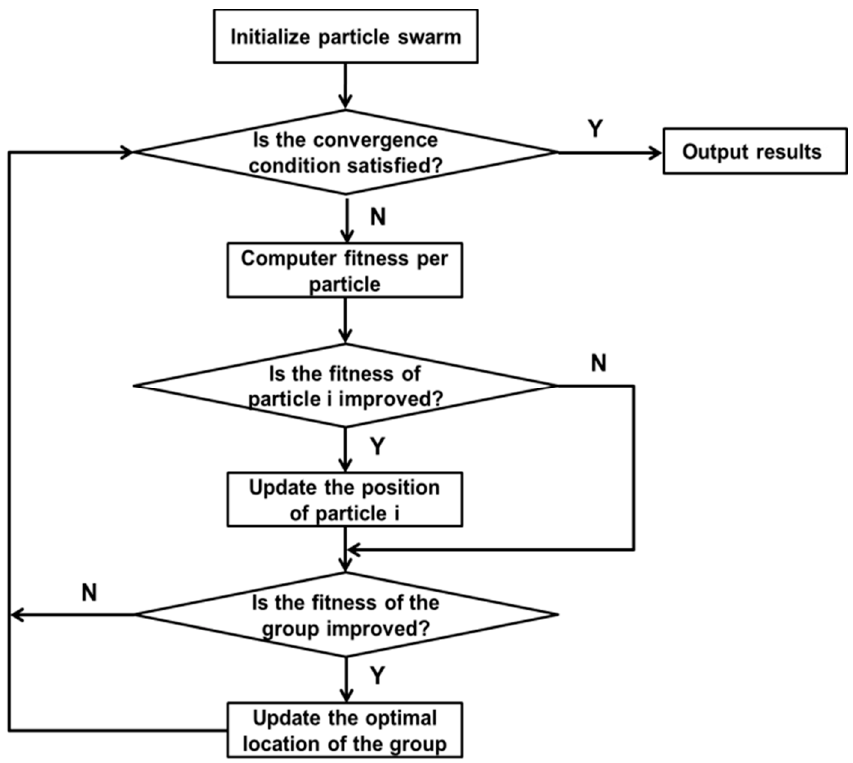
Figure 2. Description of particle swarm optimization.